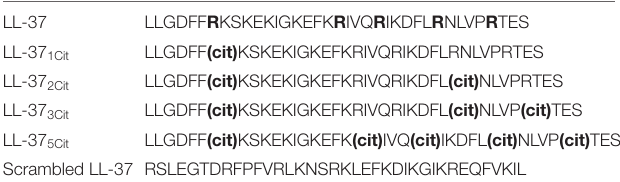
TABLE 1 | Sequences of native and citrullinated LL-37